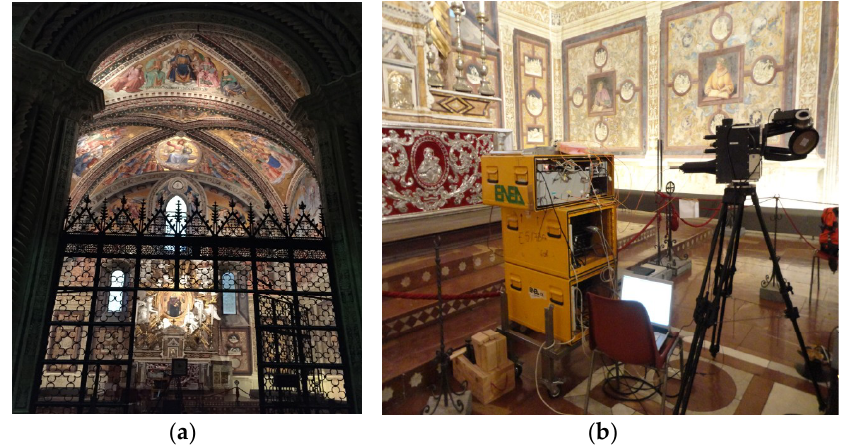
Figure 4. The Saint Brizio Chapel in the Orvieto Cathedral (Viterbo, Italy). ( a ) Picture of the Chapel from the outside shot with a Canon camera, ( b ) the RGB-ITR system working inside the Chapel (Photo: S. Ceccarelli).